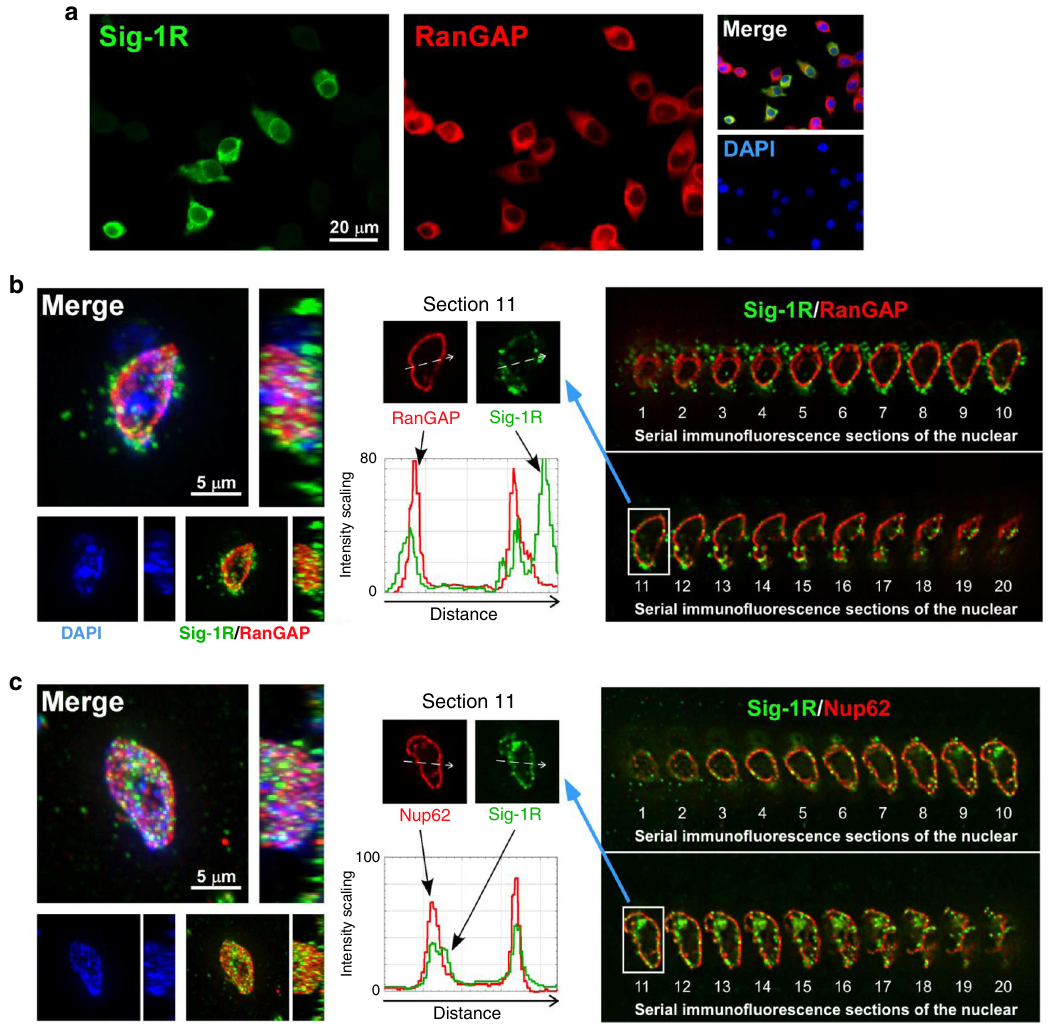
Fig. 2 Colocalization of HA-tagged Sig-1R, RanGAP, and Nup62 in differentiated NSC-34 motoneuron-like cells. a Colocalization of HA-Sig-1R with RanGAP. Cells were transiently transfected with pcDNA-HA-Sig-1R, using Lipofectamine 2000, which provided ~50% of transfection ef fi ciency in NSC-34 cells (https://www.thermo fi sher.com). Two days after transfection, cells were double-labeled with anti-HA and anti-RanGAP antibodies and examined by confocal microscopy. HA-Sig-1R, green; endogenous RanGAP, red; DNA, blue. b , c Multiple focal planes (Z sections) of the whole nuclear volume were acquired by the DeltaVision microscopy imaging systems. Results of the whole-nucleus image analysis of Sig-1R and RanGAP ( b ) or Nup62 ( c ) are shown. On left panels of b and c , square images are the top-down view ( z -axis), and rectangle panels are a side view ( x -axis) of the 3D reconstruction of images. On right panels of b and c , 20 sections were obtained from a cell. Number 1 is the Z-start at the top surface of the cellular nucleus; number 20 is Z-end at the bottom layer of the nucleus which was near the attachment of the cell to the coverslip. On central panels, white dotted arrows in images of the two sections 11 indicate the track of fl uorescence intensity pro fi les (ImageJ: Plot Pro fi le command) along the arrows. A shift of each focal plane in the Z -axis is 0.25 μ m. Three-dimensional reconstructions were made from the Z-series images. Again: HA-Sig-1R, green; endogenous RanGAP/Nup62, red; DNA, blue. Sig-1R, Sigma-1 receptor, RanGAP RanGTP-activating protein, Nup62 nucleoporin 62. n = 3 independent experiments with similar results from biologically independent